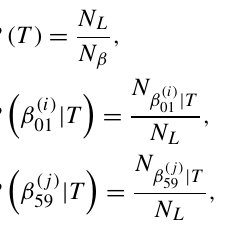
(cid:16) (cid:17) β (i) ,β (j) of the 01 59